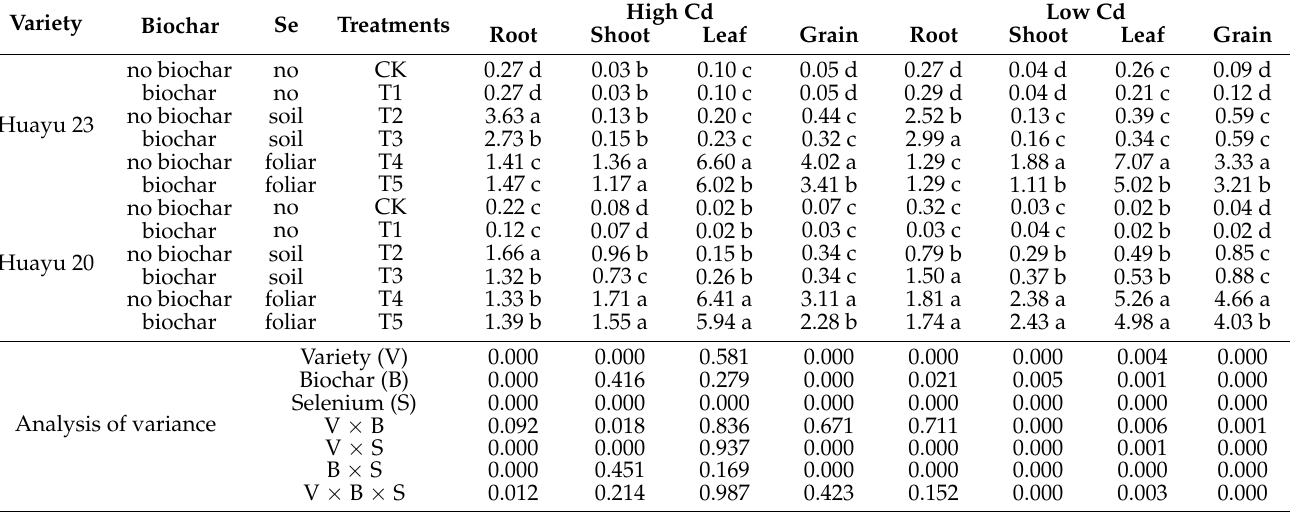
Table 3. Selenium content (mg · kg − 1 ) in the roots, stems, leaves, and grains of Huayu 23 and Huayu 20 under different